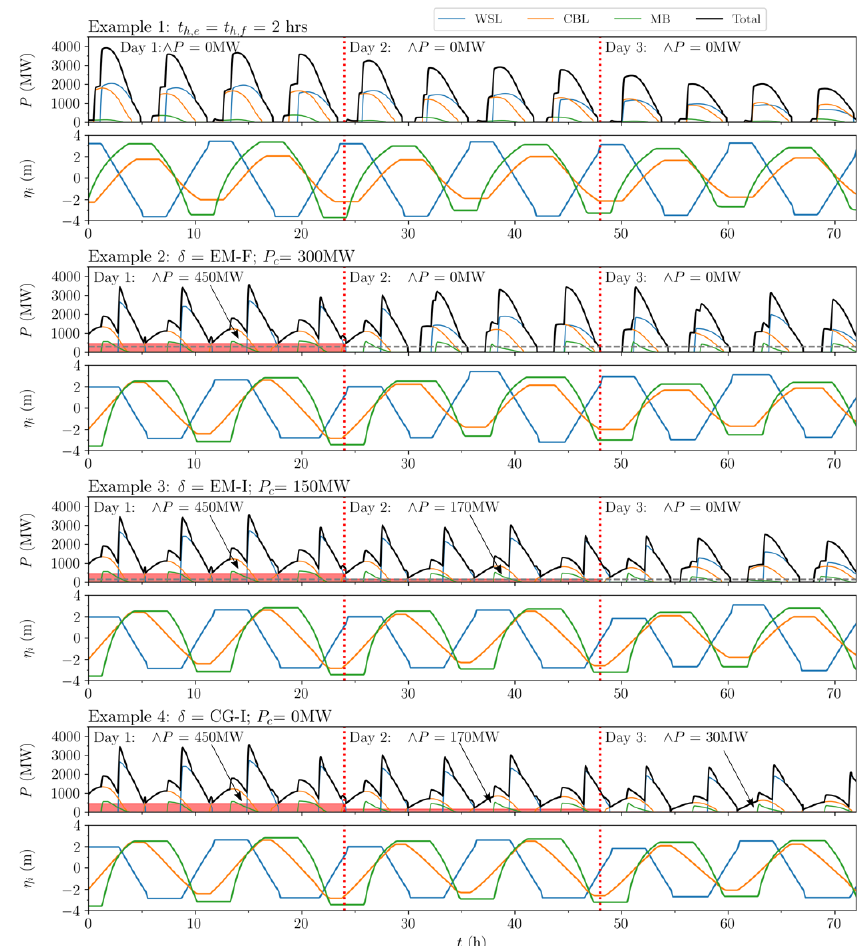
Figure 4. Power output P (MW) and basin elevations η i (m) of the tidal power plants. Example 1 indicates a scenario where the holding periods t h , e = t h , f = 2 h for each scheme. Examples 2–4 display BG-F optimised schedules, applying different examples of “default” δ , defined as the operation schedule reverted to when cut-off power P c (MW) cannot be achieved in the CG-F case. Daily minimum power ∧ P (MW) determines the power sold on the Baseload Market (BM), indicated with